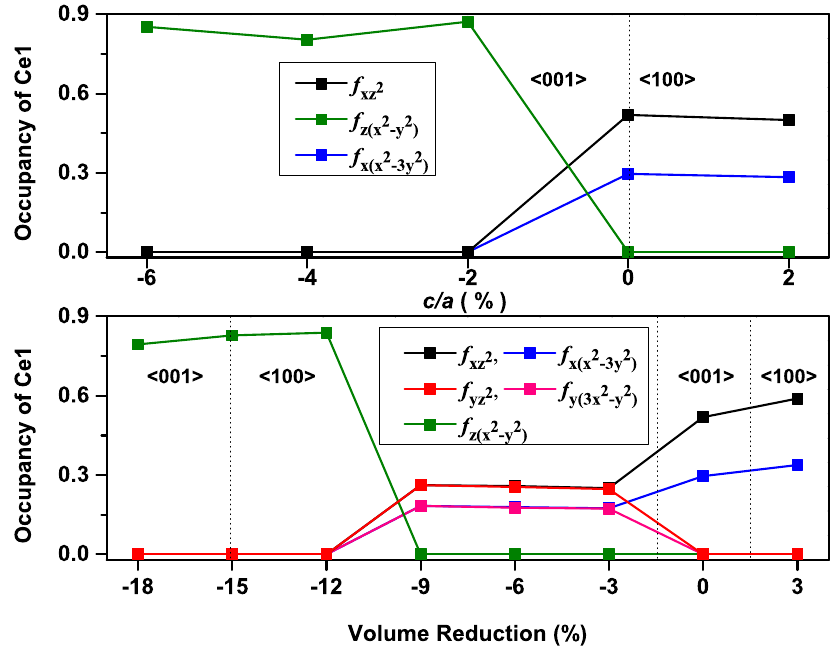
Figure 5. The same as Figure 4 except for the CeAgSb 2